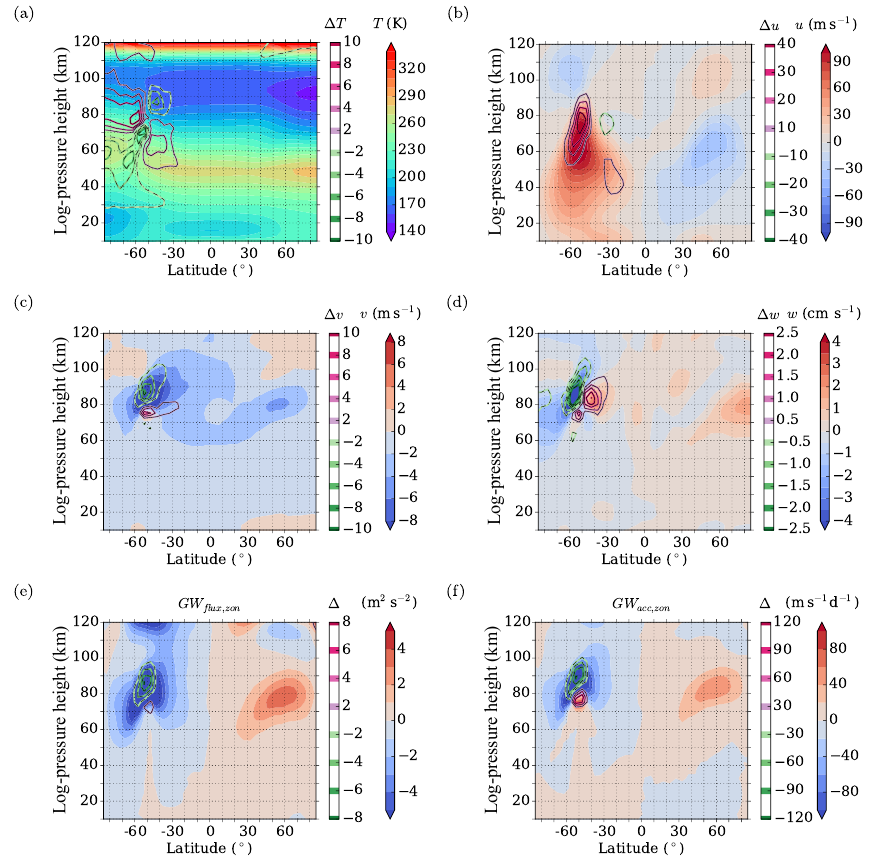
Figure 6. Background colors: Run3 zonal mean parameters for (a) temperature, (b) zonal wind, (c) meridional wind, (d) vertical wind, (e) zonal GW momentum flux, and (f) zonal acceleration of the mean wind by GWs. Isolines: differences of these parameters for Run3– Run2. For both runs, GW weights in the GW parameterization routine have been selected as a 2-D horizontal field according to Fig. 1a, but for Run2 SPW forcing is enabled and disabled for